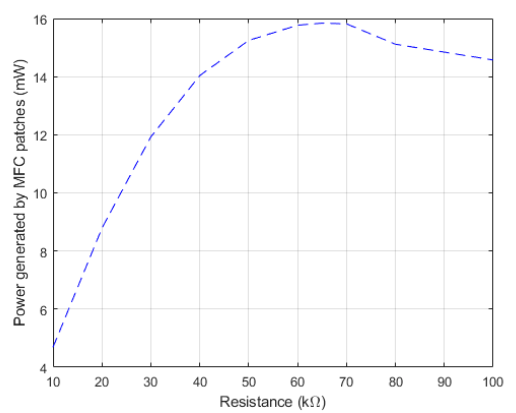
Figure 6. Simulated power generated by the piezoelectric cantilever